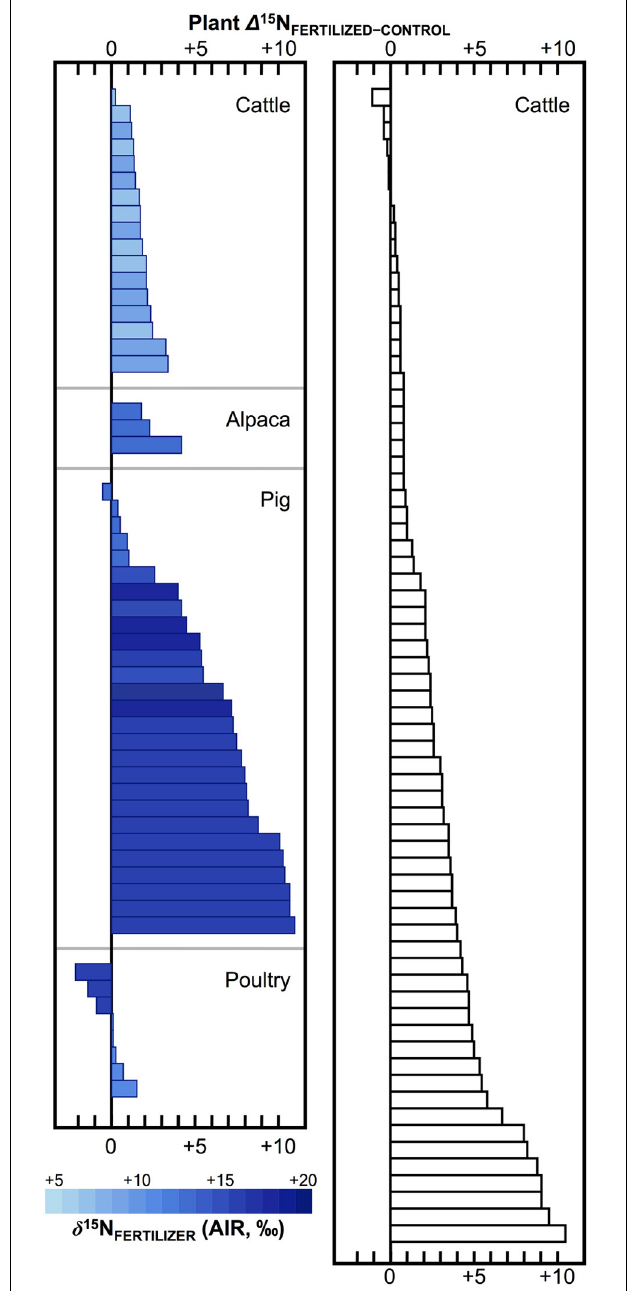
FIGURE 4 | Effects of animal fertilizers on plant δ 15 N values. Bars represent differences between control plants (no fertilizer applied) and treatments receiving animal fertilizers. Bars are shaded according to δ 15 N of the fertilizer applied, with darker colors representing higher δ 15 N values; open bars indicate fertilizer δ 15 N value was not determined (right panel). Data are compiled from published literature (Choi et al., 2002; Watzka et al., 2006; Yun et al., 2006; Lim et al., 2007; Yun and Ro, 2009; Fraser et al., 2011; Szpak et al., 2012b; Yuan et al., 2012; Zhou et al., 2013). Studies contrasting chemically and organically fertilized plants without unfertilized controls were not included. For readability, results from plants fertilized with seabird guano (differences between fertilized and control plant δ 15 N + 20 to + 40 (cid:2) ) were excluded (Szpak et al., 2012a,b, 2014).